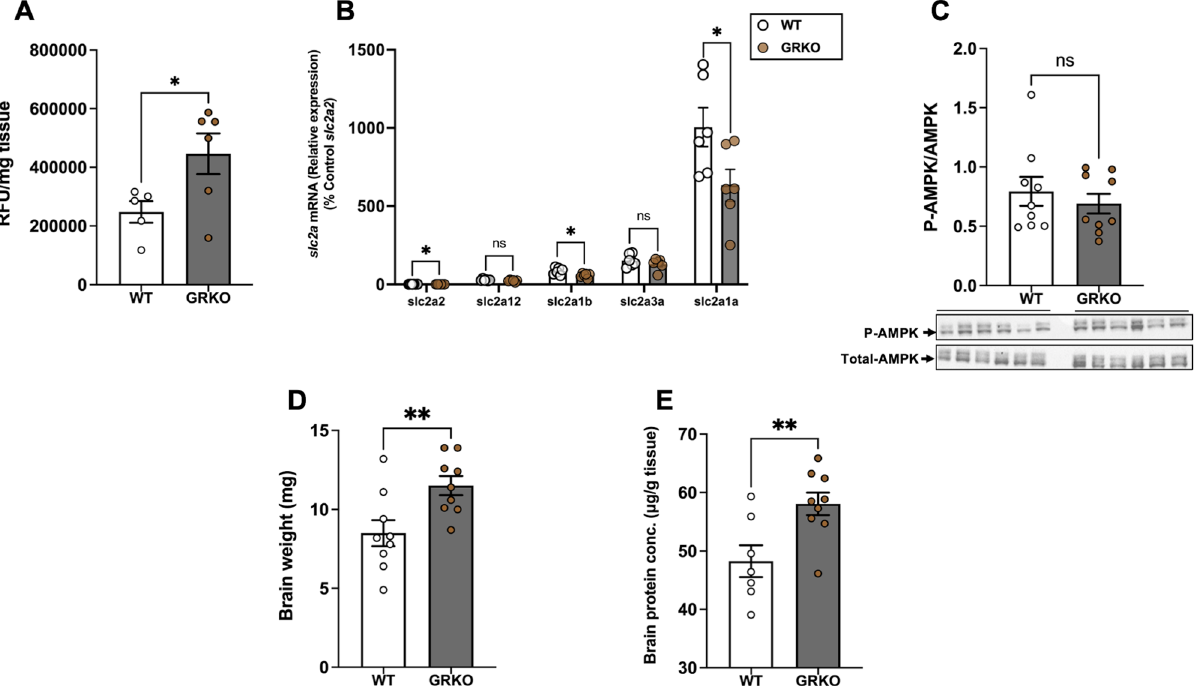
Figure 8. Loss of GR increases brain glucose uptake. ( A ) GRKO fish had significantly higher uptake of the fluorescent glucose analogue 2-NBDG in the brain than the WT. ( B ) The transcript levels of slc2a1a , slc2a1b and slc2a2 in the brain was lower in the GRKO fish compared to the WT, but the expression of slc2a3a and slc2a12 remained unchanged. ( C ) Loss of GR did not change the ratio of phosphorylated to total AMPK (M.W. 62 kDa) in the brain. ( D ) GRKO fish had significantly higher brain mass compared to the WT. E. Brain protein concentration was significantly higher in the GRKO fish compared to WT. Values are means ± SEM (Relative fluorescence units; RFU n = 5–6; Transcript abundance n = 6; AMPK expression n = 9; Brain wet weight n = 9; Brain protein concentration n = 7–9). ns—not significant; *( P < 0.05); **( P <